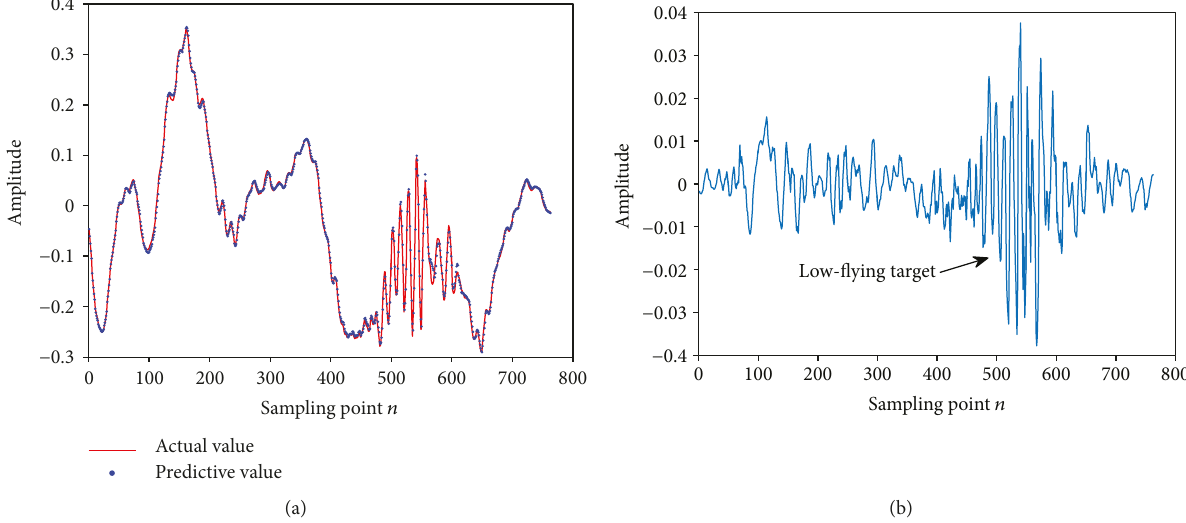
Figure 8: Chaotic prediction of the #54 8th distance gate sea clutter after de-noising. (a) Real value and Volterra predicted value. (b) The prediction